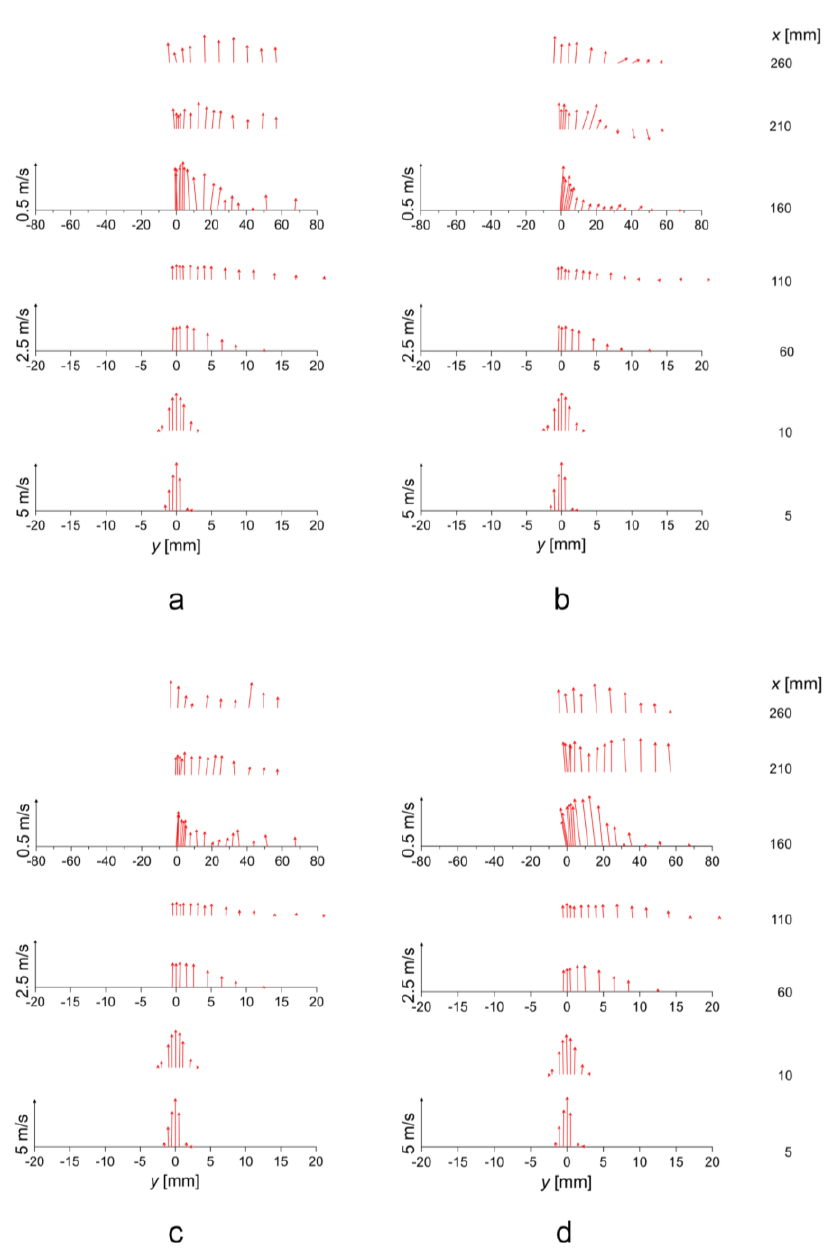
Figure 7. Phase-averaged flow patterns of velocity vectors of Run 1 of Table 1 acquired at a time rate of one-quarter of the wave period: ( a ) wave trough to crest passage; ( b ) under the wave crest; ( c ) wave crest to trough passage; ( d ) under the wave trough.